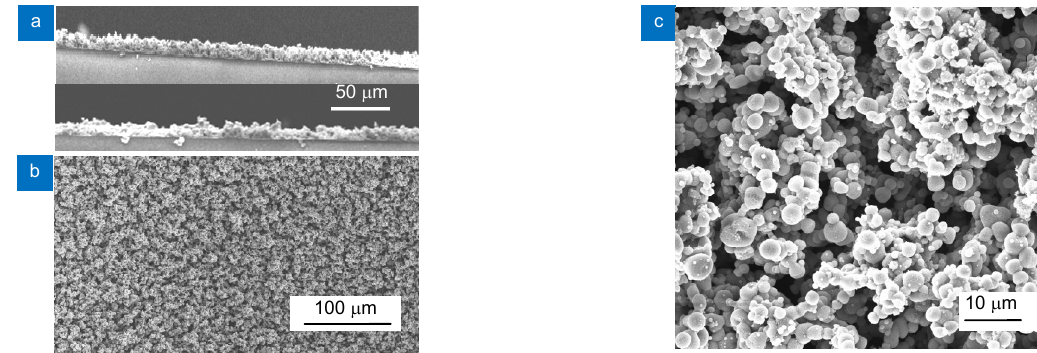
Fig. 14 | Multiscale of porous structures fabricated by electrospraying dense P25 suspensions . SEM images of the electrosprayed film from dense P25 suspensions to the substrate heated at 150  C and 250  C 36 . (a) Side view of the film showing decent film uniformity. (b) Top view of the electrosprayed film. (c) Closeup of the electrosprayed film showing the multiscale nature of the photo